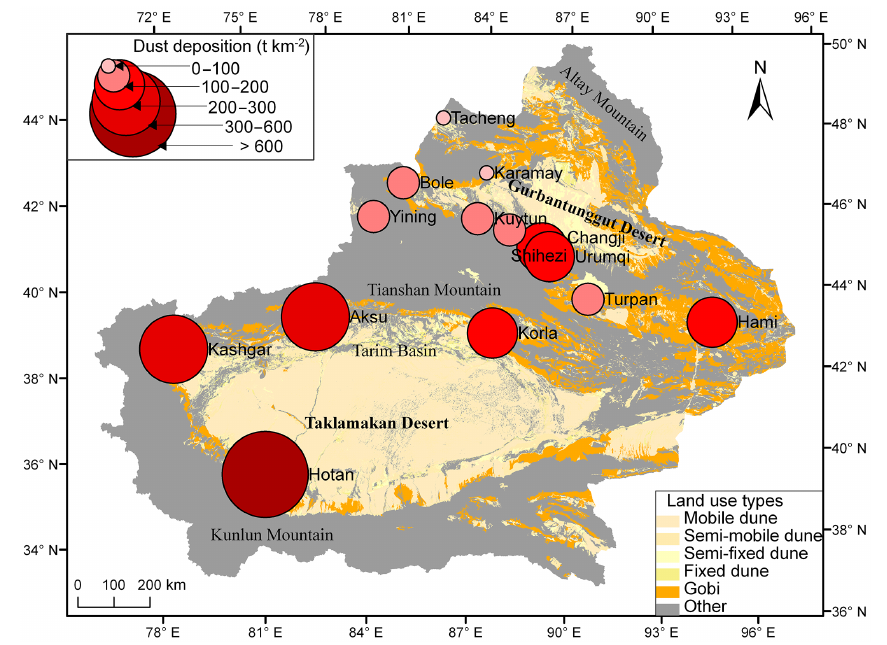
Figure 2. Annual average dust deposition reported at 14 stations in Xinjiang Province from 2000 to 2013. Land use types across the province are identified according to Wang et al.